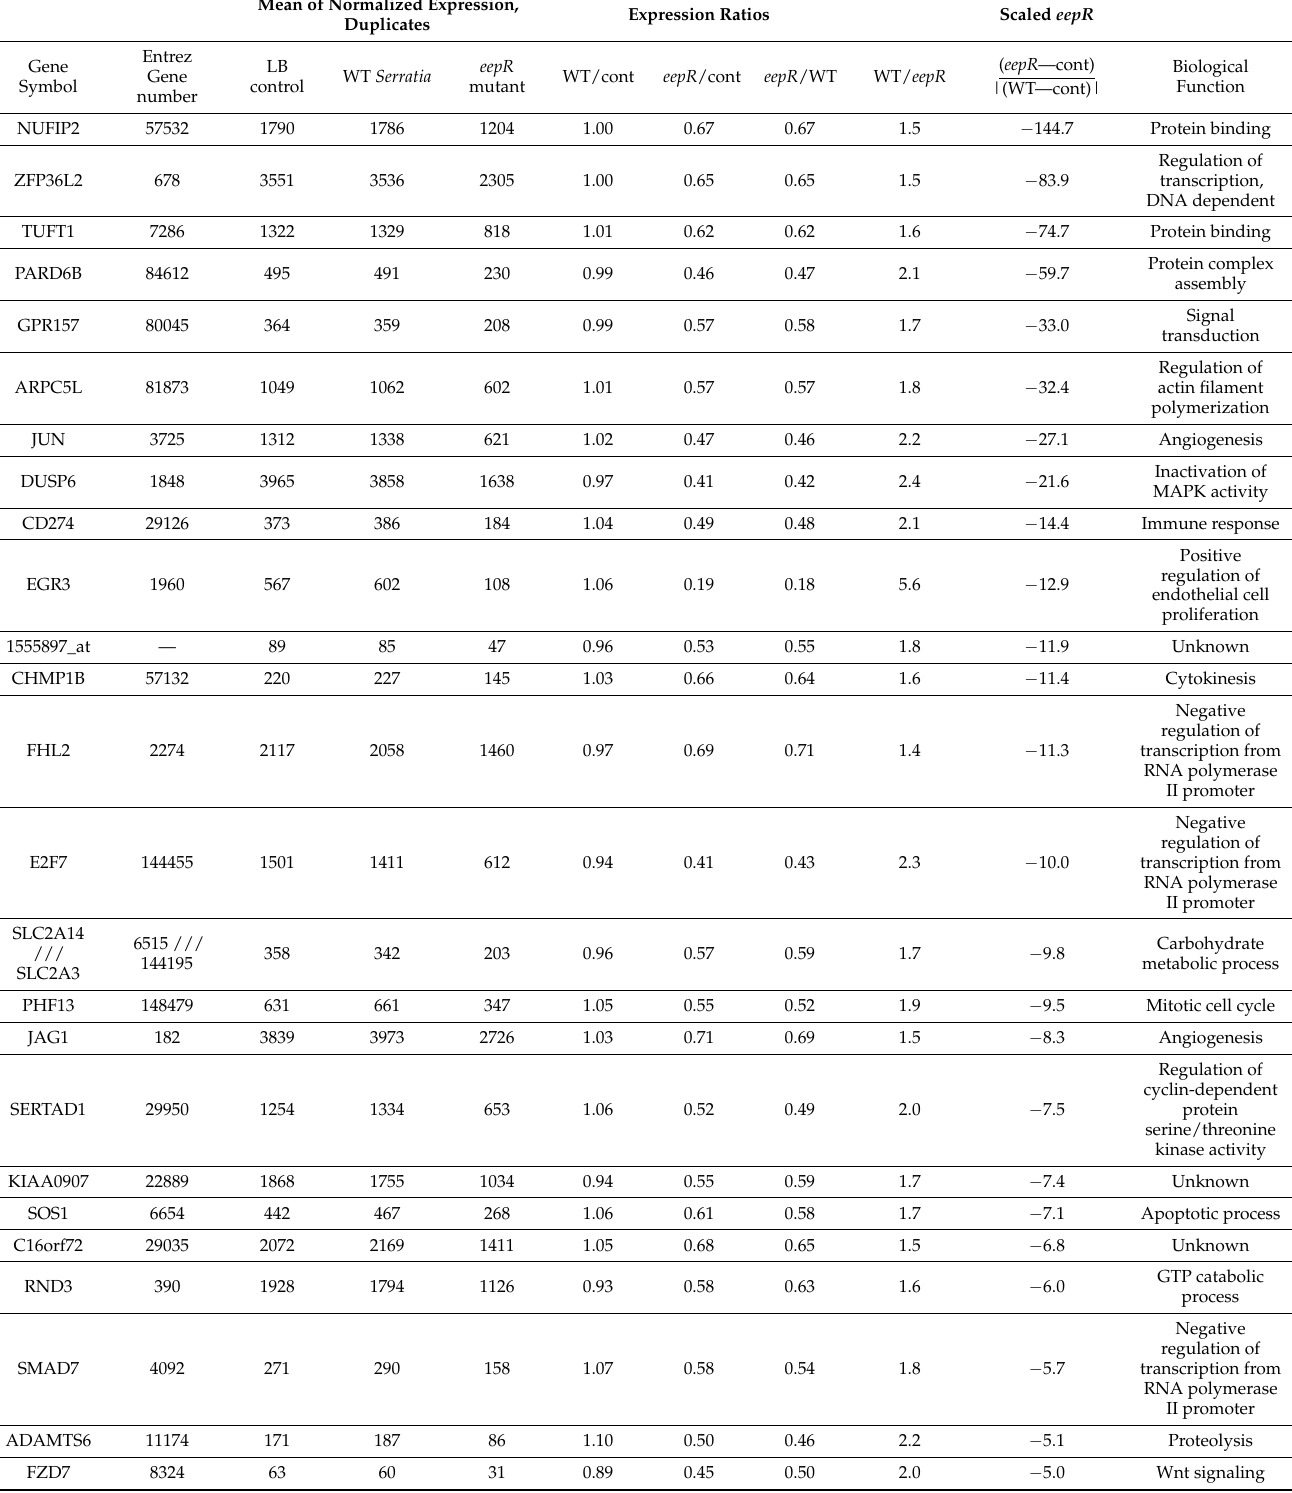
Table 6. Twenty-five genes with the lowest scaled eepR values (i.e., relatively little effect of WT, relatively large decrease by eepR). Mean of Normalized Expression, Duplicates Expression Ratios Scaled